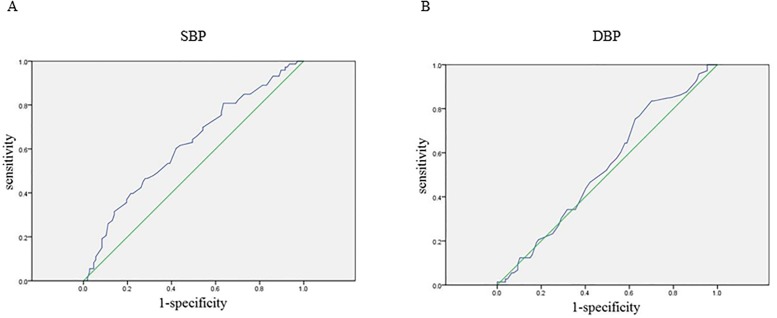
ROC curves to evaluate the cut-off values of SBP and DBP to predict IMT-max above 1.8 mm.(A) SBP, (B) DBP.